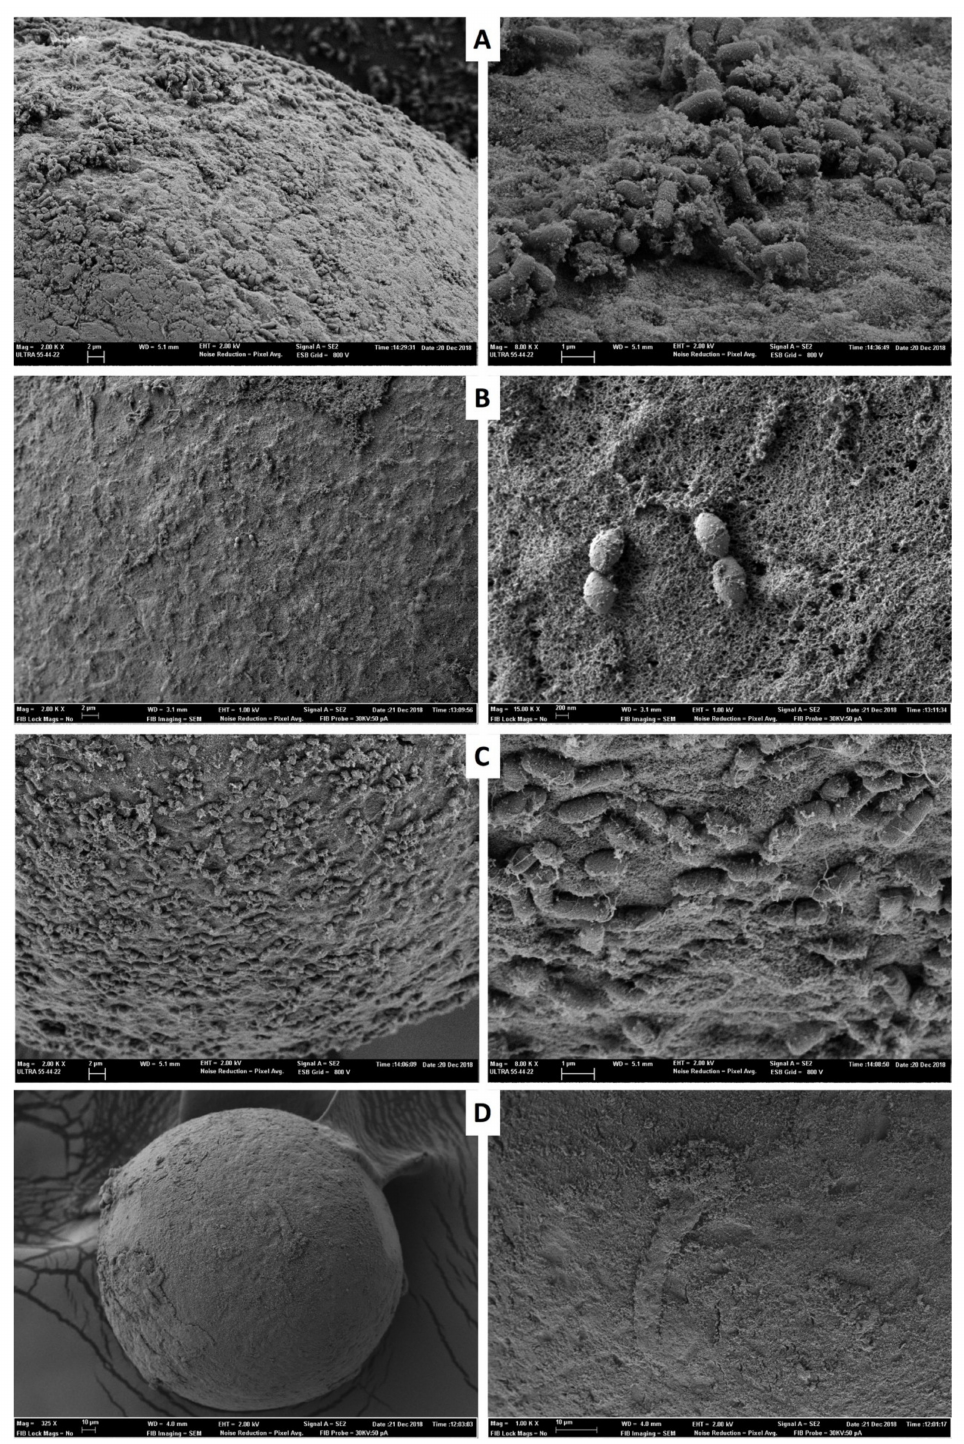
Figure 3. Representative scanning electron microscopy of rabbit embryo surfaces infected with pathogens after vitrification-thawed procedure. ( A ) Salmonella enterica Typhimurium (ATCC14028) (magnification of 2.00 KX, left and 8.00 KX, right). ( B ) Staphylococus aureus (ATCC6538) (magnification of 2.00 KX, left and 15.00 KX, right. ( C ) Enterobacter aerogenes (ATCC13048) (magnification of 2.00 KX, left and 8.00 KX, right. ( D ) Aspergillus brasiliensis (ATCC16404) (magnification of 325 X, left and 1.00 KX,